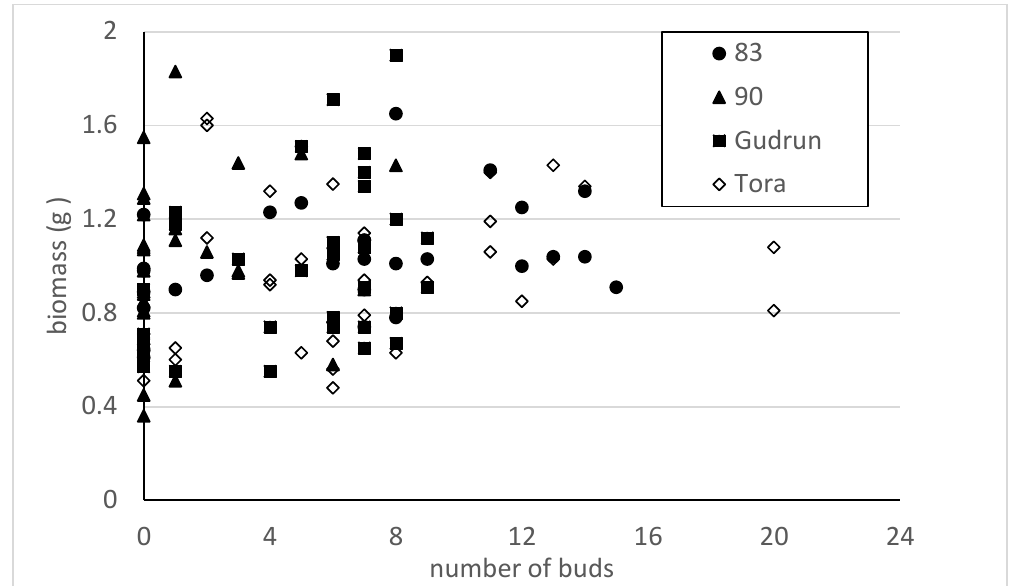
Figure 6. Relationship between the number of visible buds on the cuttings and cutting total biomass production for different clones in 2010.